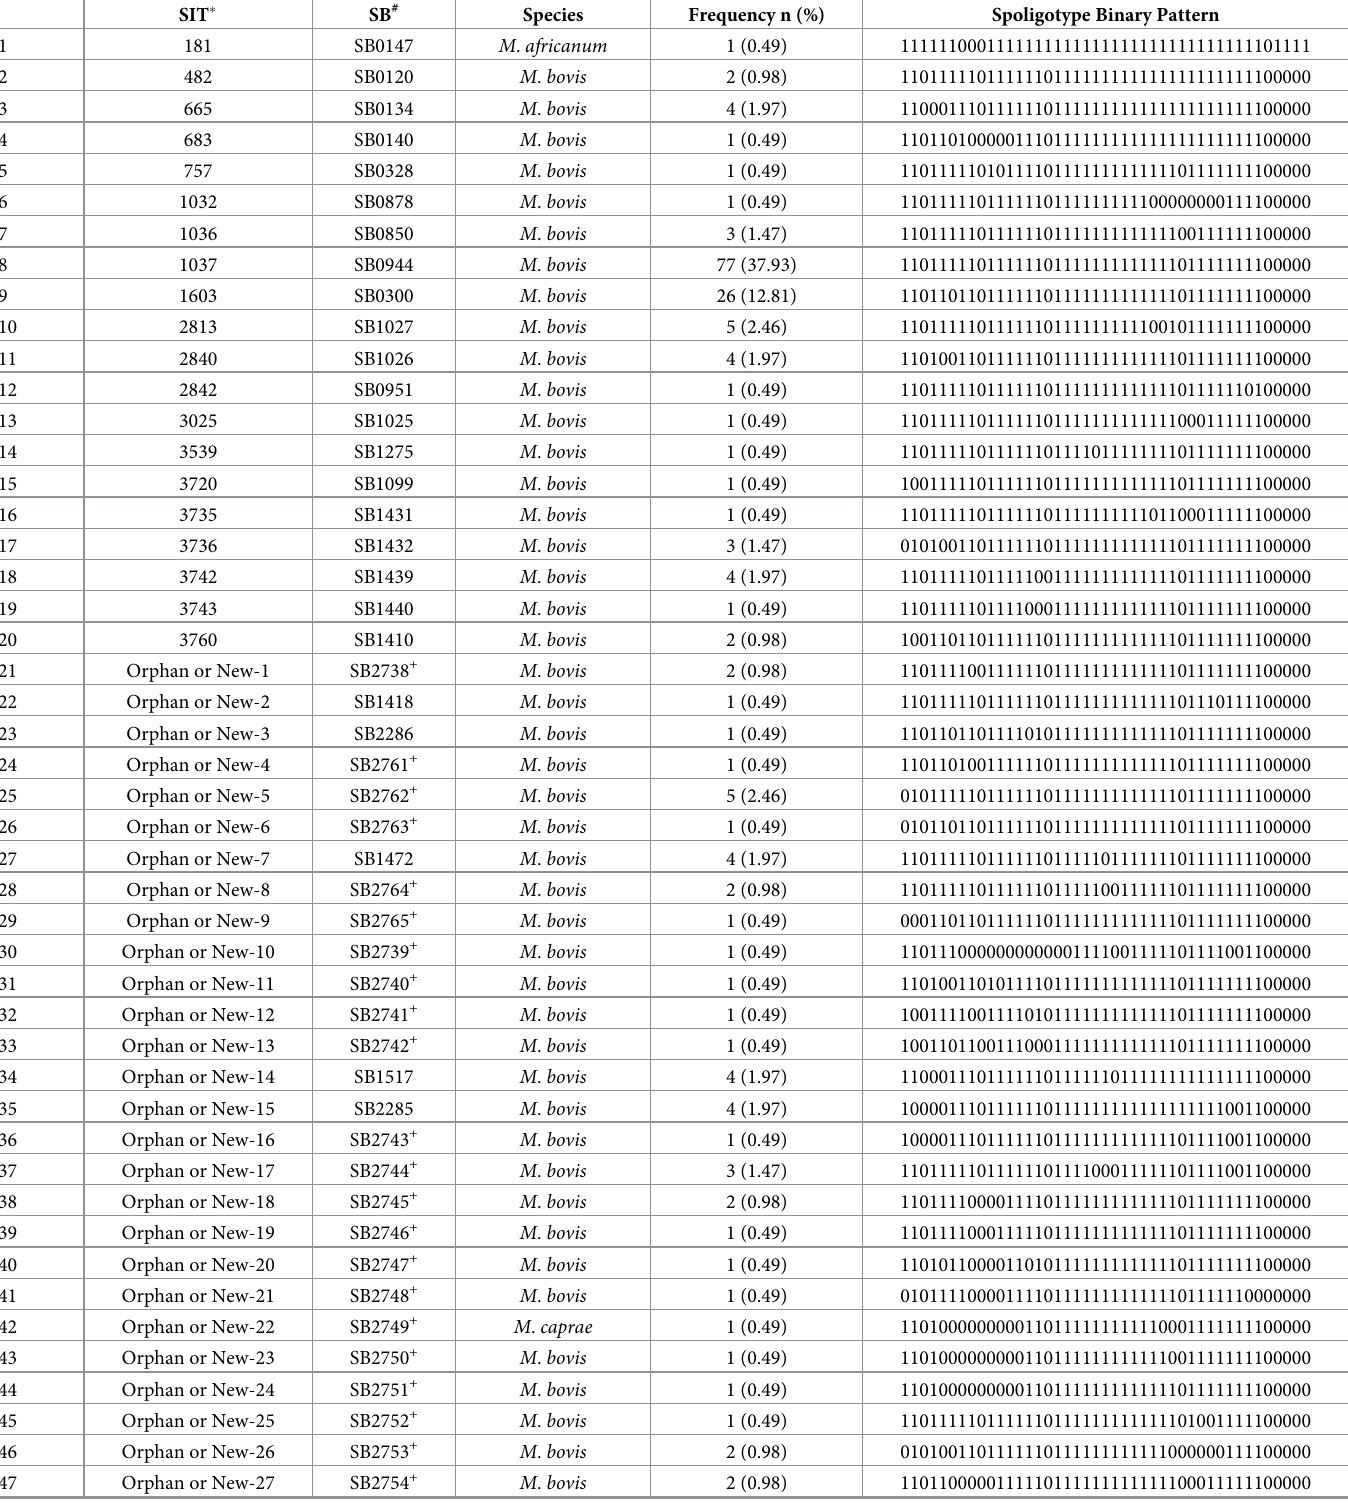
Table 3. Identified spoligotype